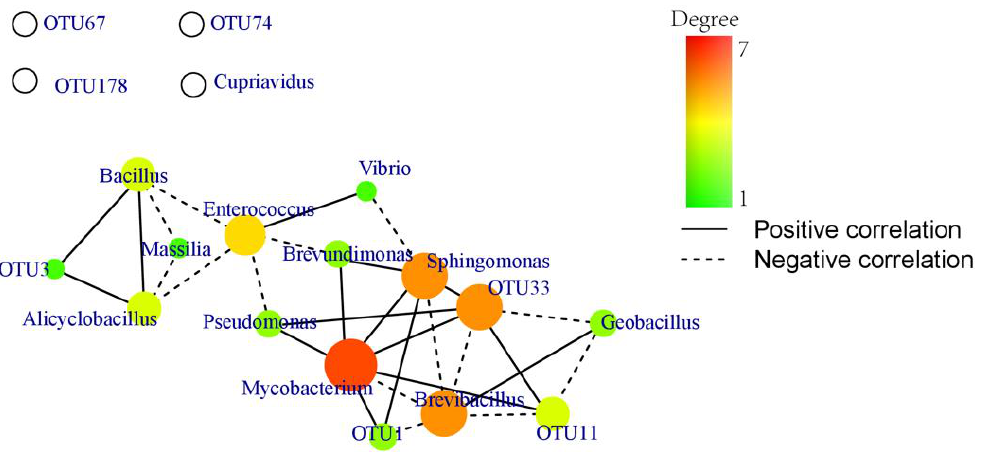
Figure 6. Covariation network of core bacterial genera and outs of Tulasnella species in Paphiopedillum armeniacum . Degree: the number of microbial genus associated with other genus. The value of degree increases gradually from green to red.